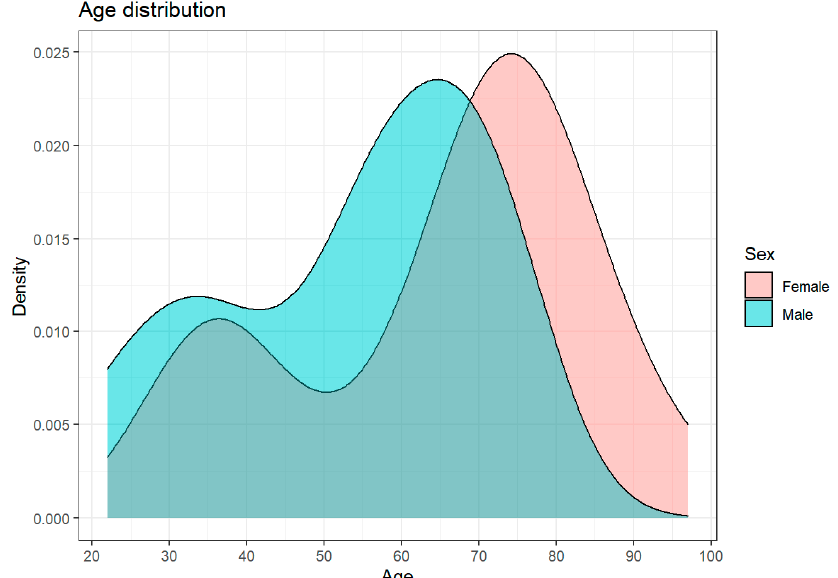
Figure 1. Age distribution with two peaks caused by traumas (first peak) and infections (second peak), being the main indications for keratoplasty in younger and older patients, respectively.